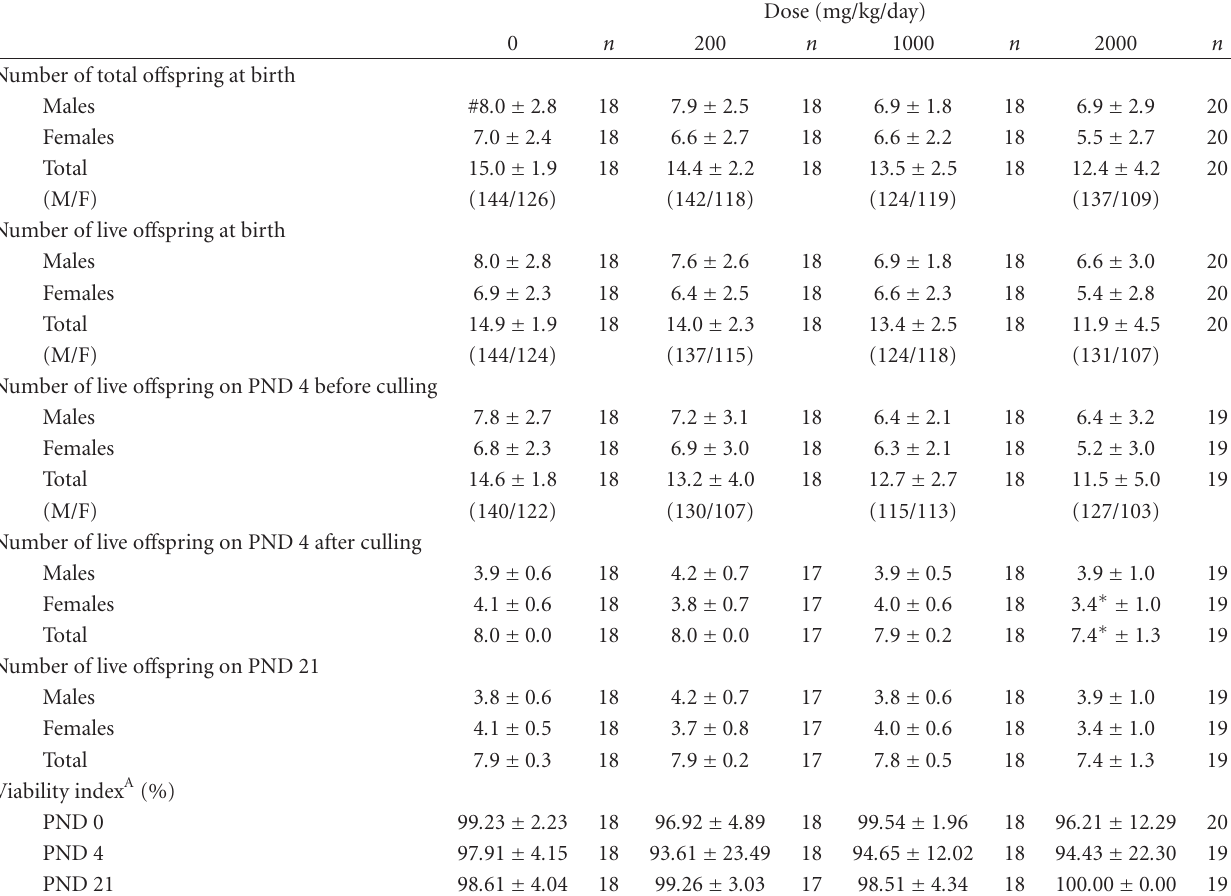
Table 11: Litter size and viability index of the F 2 generation rat pups exposed to SE5-OH during gestation through